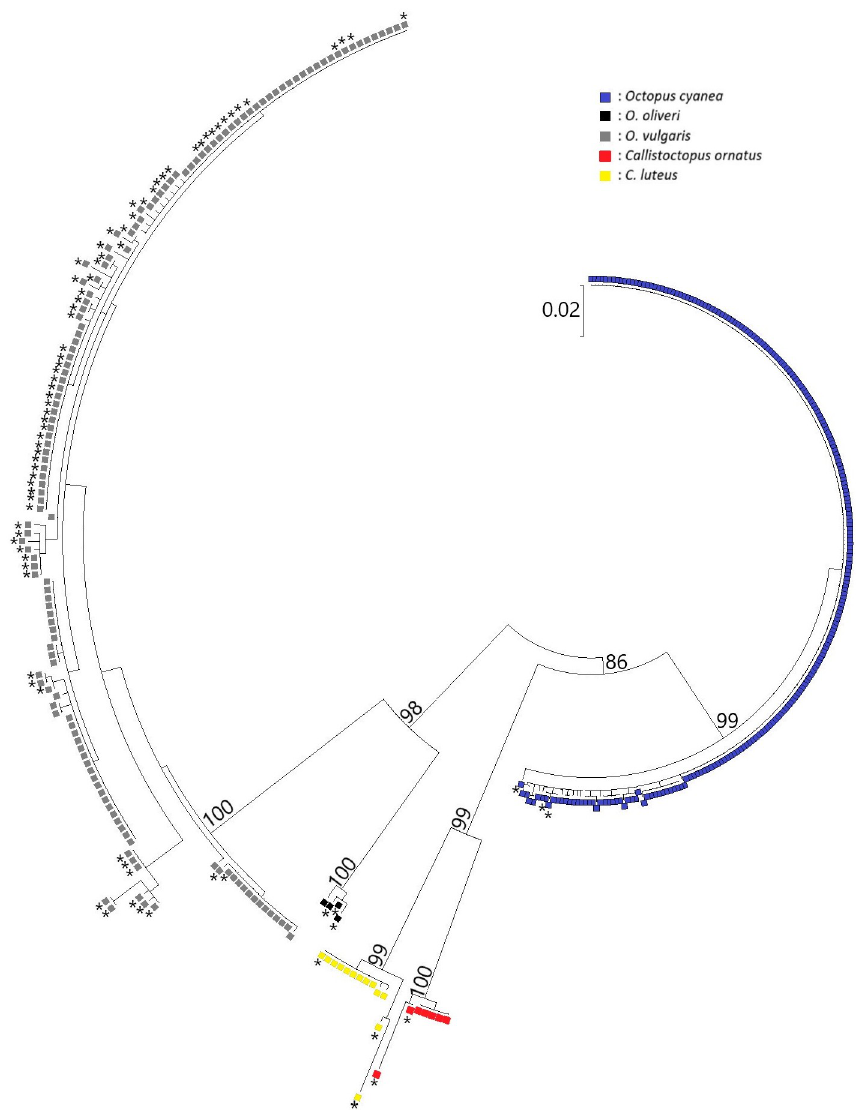
Fig 2. Neighbour-Joining (NJ) tree of all octopus samples and reference sequences downloaded from BOLD Systems ( � ). Bootstrap values are indicated at the major branches. Individuals of the same species are clustered